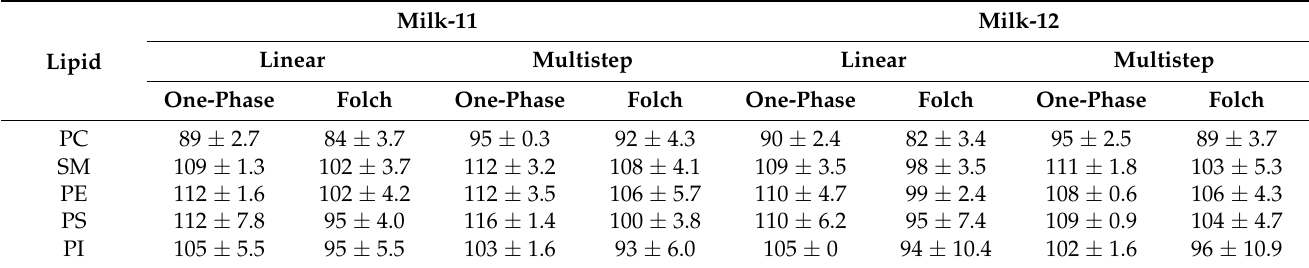
Table 1. Matrix effect (%) in relation to lipid extraction methods and LC elution